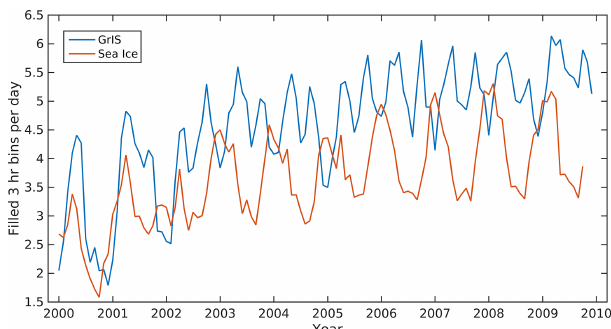
Figure 9. Average number of filled 3h bins per day for the Green- land Ice Sheet and the Arctic sea